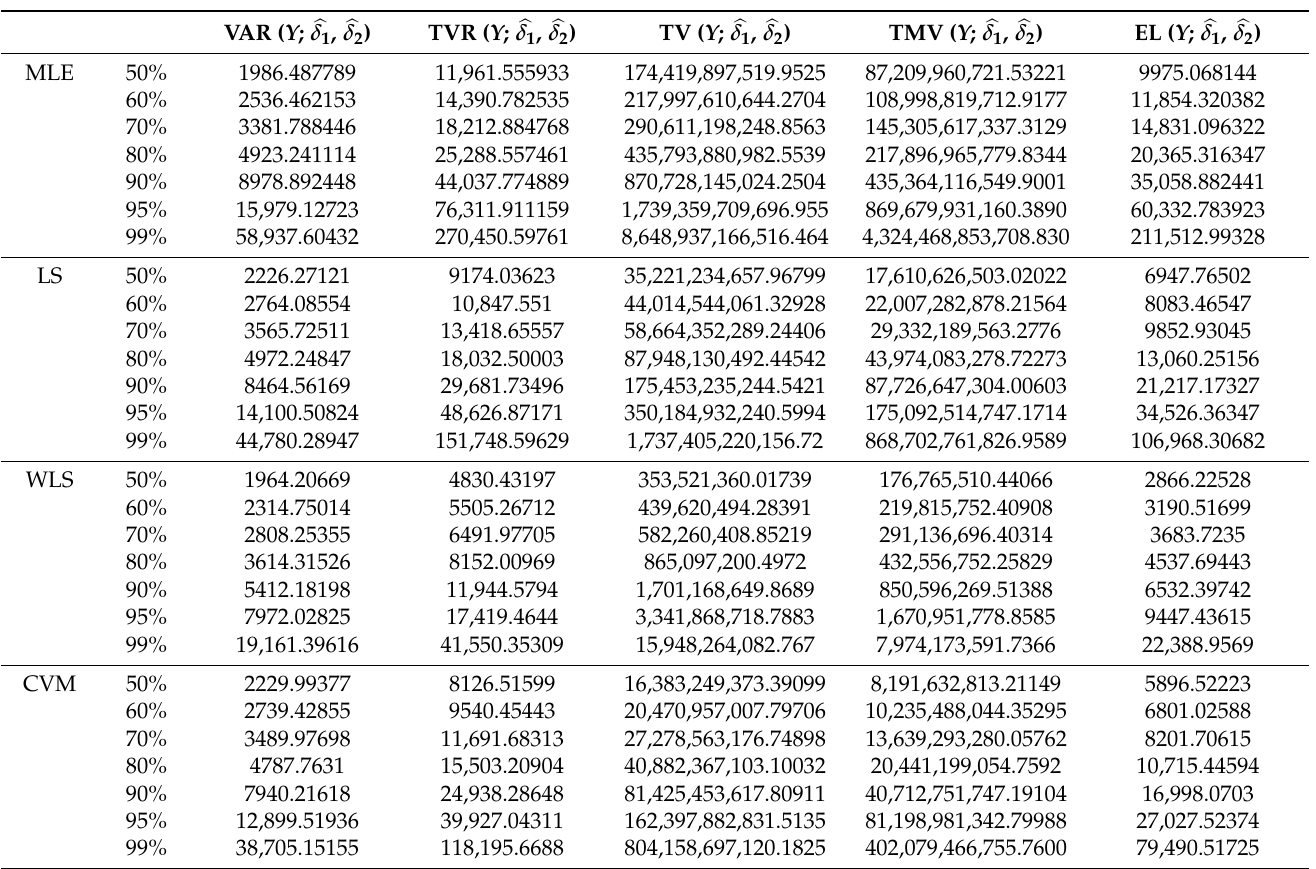
Table 13. The KRIs for the RW under insurance claims data.